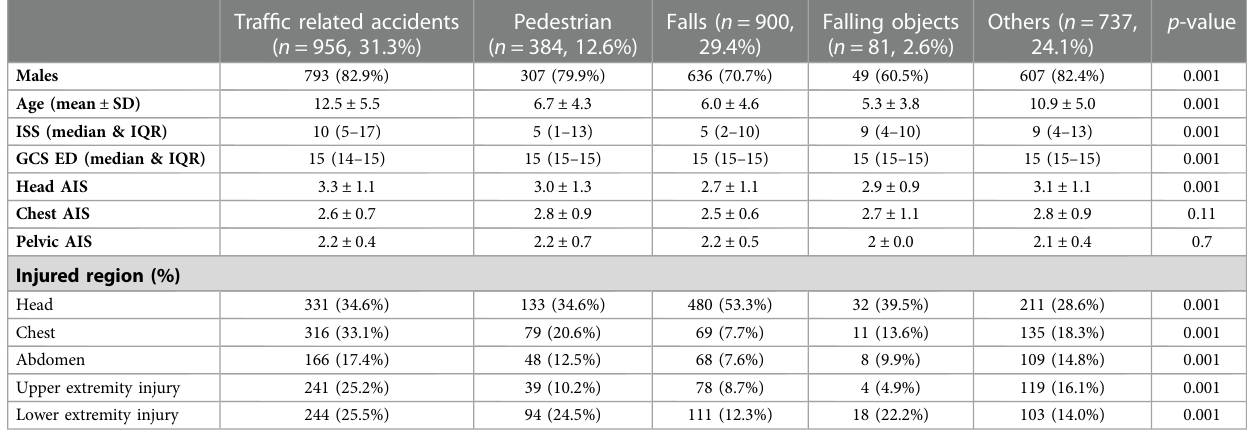
TABLE 3 Demographics and characteristics of pediatric traumatic injuries by mechanism of